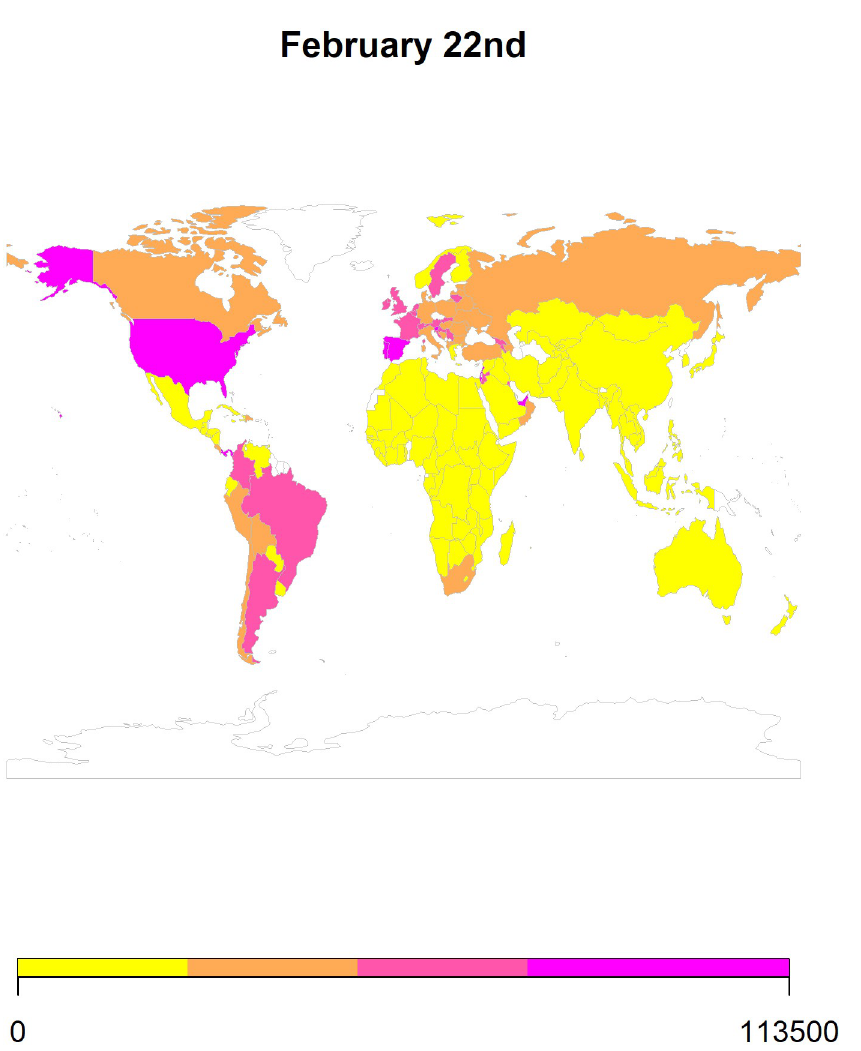
Fig 9. The heat map using the ARIMA forecasts for 22 nd February